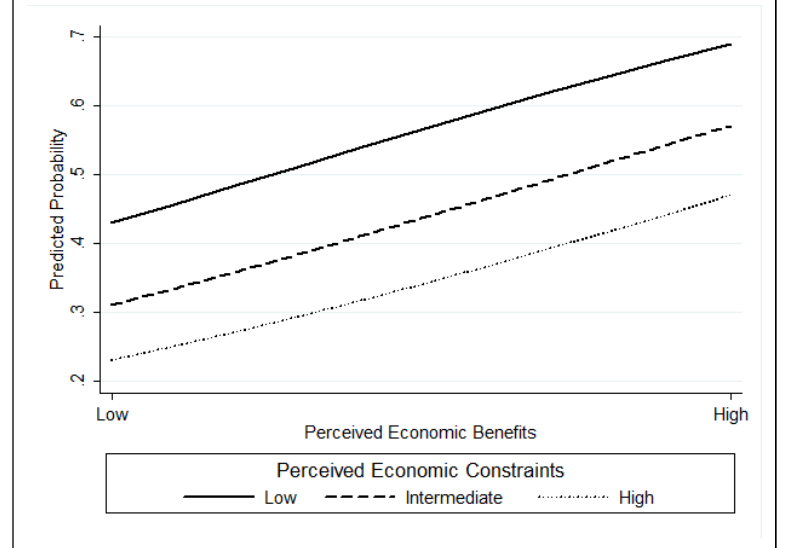
Figure 1. Predicted Probability of Adopting Organic Farming Practices as a Function of Perceived Economic Benefits Low, intermediate, and high are calculated as the 25th, 50th, and 75th percentile. All other values are held at their mean using model 2 parameters.